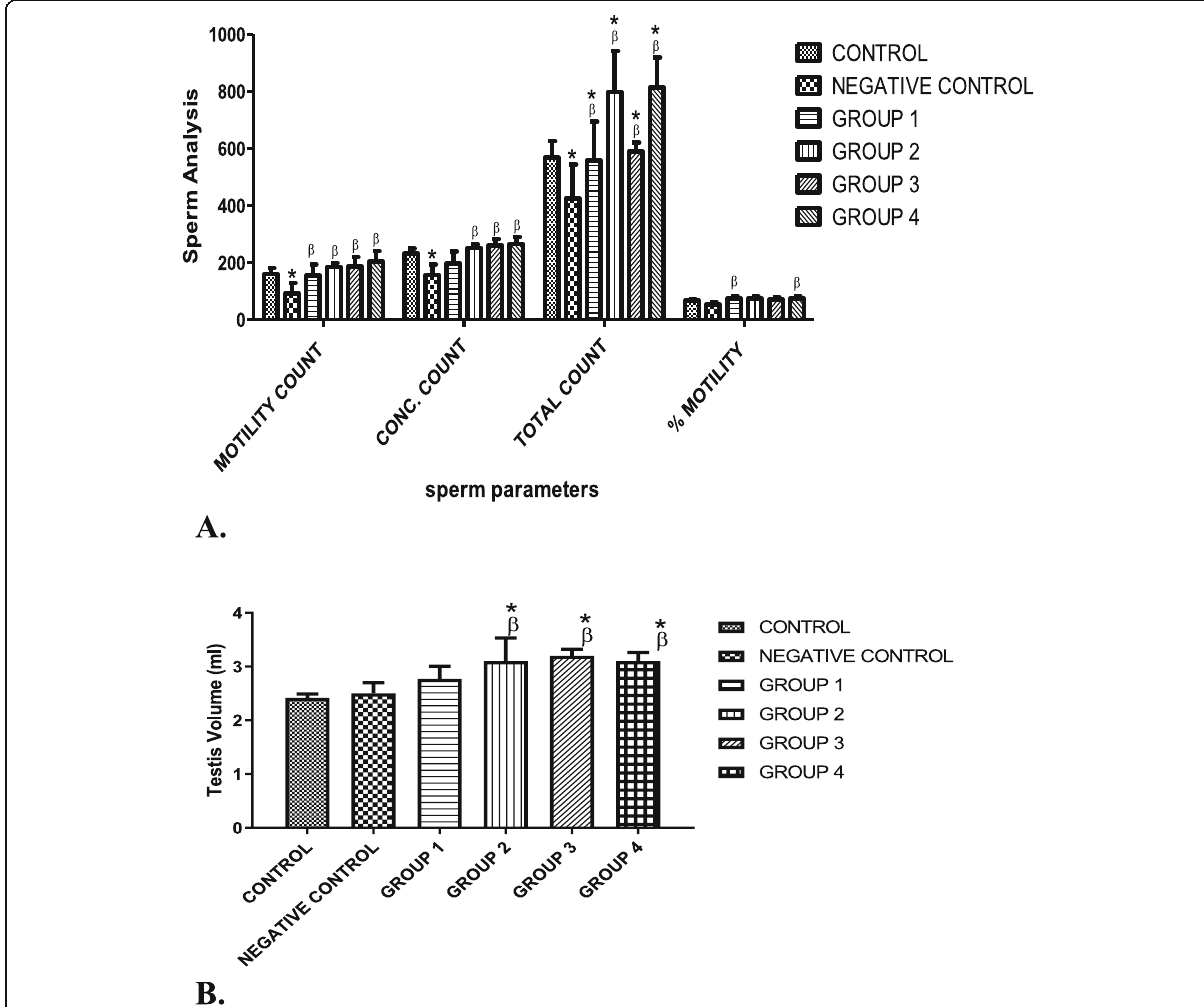
Fig. 1 a Graphical representation of semen analysis parameters. Control groups were compared with the other groups; (*) showed that they were significant. Negative control groups were compared with the other groups; ( β ) showed that they were significant. b Graphical representation of semen analysis parameters. Control groups were compared with the other groups; (*) showed that they were significant. Negative control groups were compared with the other groups; ( β ) showed that they were